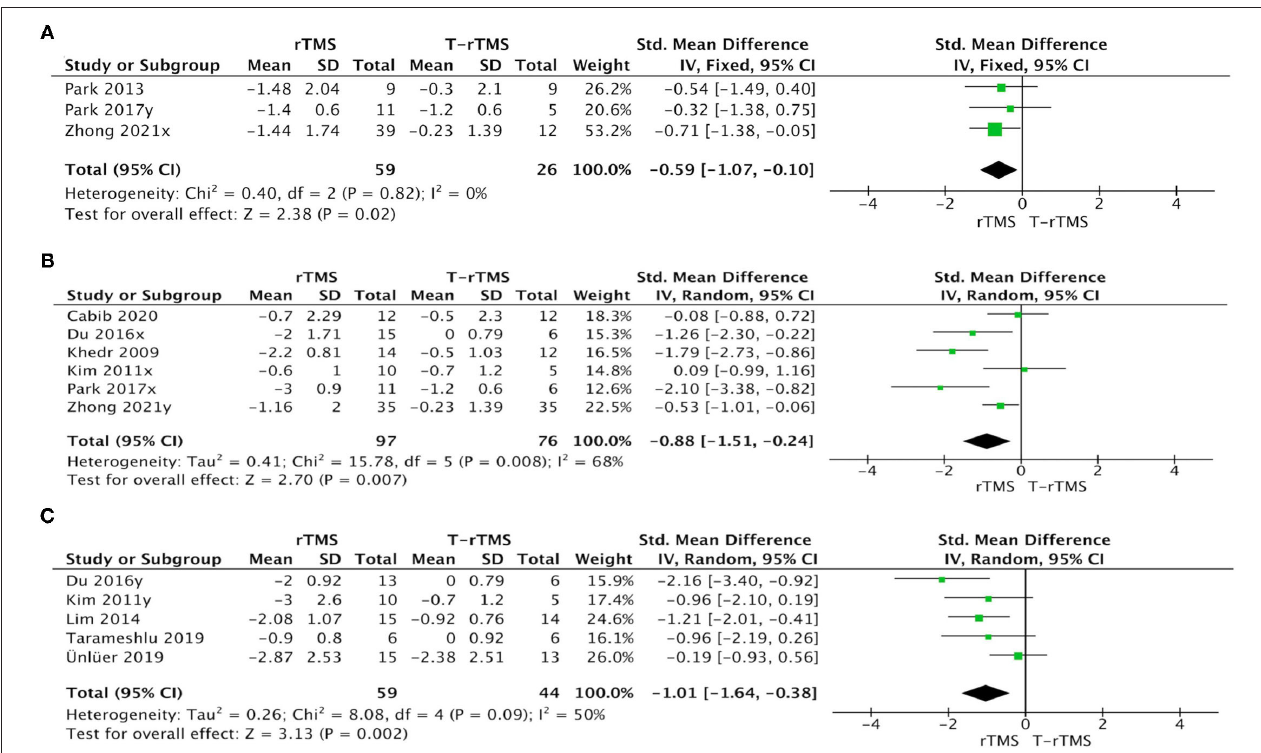
FIGURE 6 | Subgroup analysis of primary outcomes: forest plot of the standardized mean difference (SMD) for change scores in dysphagia severity rating scales by the stimulation pattern. (A) High-frequency in unaffected hemisphere. (B) High-frequency in affected hemisphere. (C) Low-frequency in unaffected hemisphere.